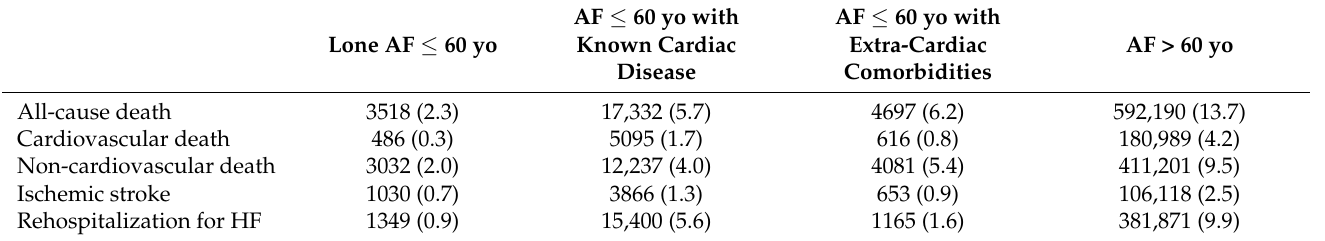
Table 2. Clinical outcomes during entire follow-up in AF